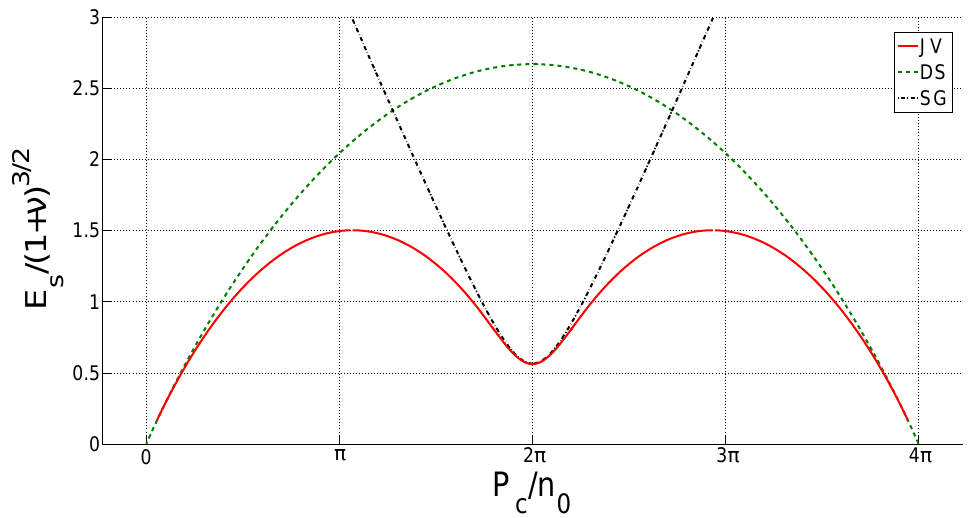
Figure 15: Dispersion relation of the coupled BECs model and the sine-Gordon equation with γ = 1, ν = 0.005. Green dashed line – dark solitons (labeled ‘DS’), red solid line – Josephson vortices (labeled ‘JV’), black dash-dotted line – sine-Gordon solutions (labeled ‘SG’). The Josephson vortex dispersion relation is very close to the sine-Gordon dispersion relation = 2 π ( 1 + ν ) (note that this latter curve was shifted horizontally to P about P c